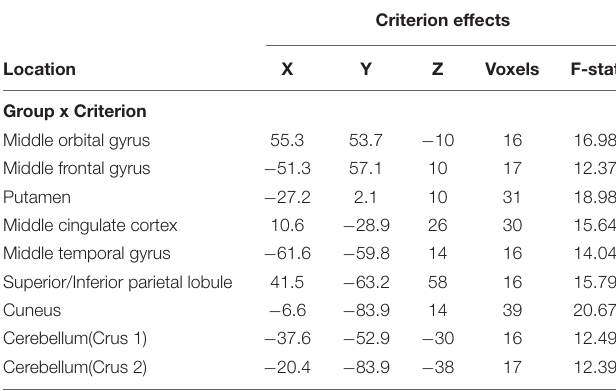
TABLE 4 | Group × Criterion (response bias)